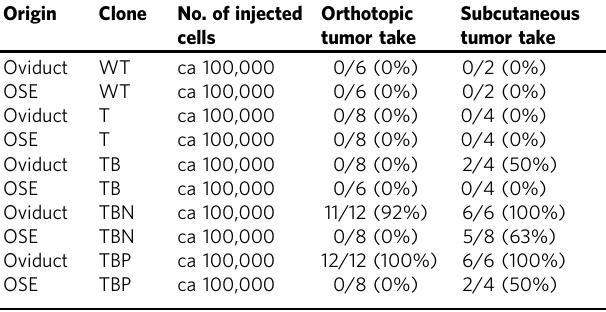
Table 1 Summary table of transplantation outcomes with oviductal and OSE